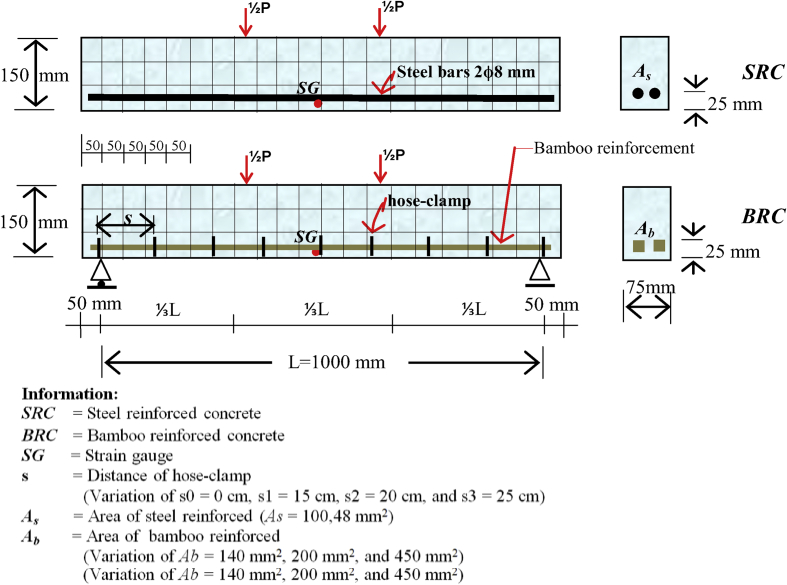
Detail and geometry of the bamboo reinforced concrete beam [1,4].